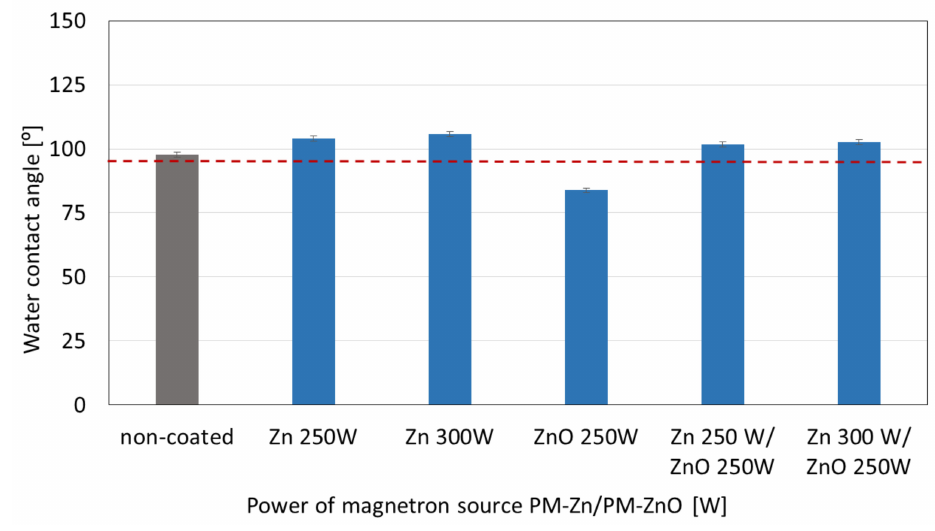
Figure 6. The results of the water contact angle measurements for one-component Zn and ZnO coatings and two-component Zn/ZnO coatings created by different magnetron power sources.